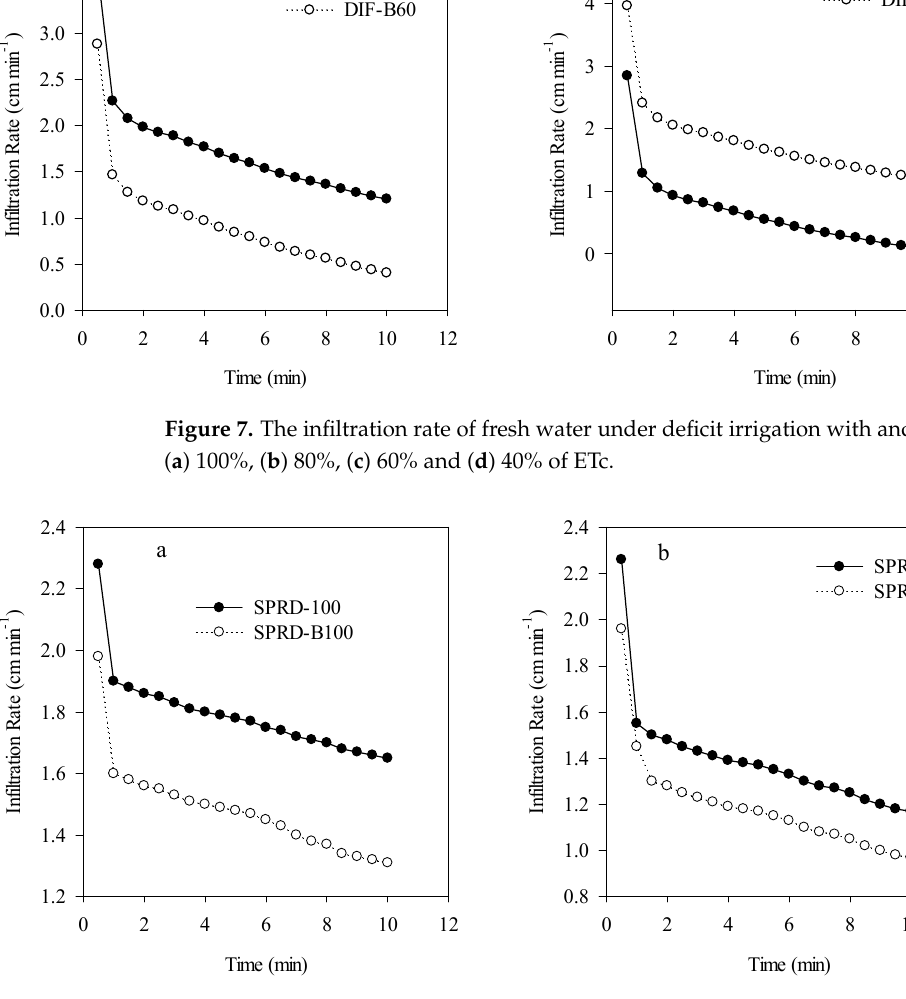
Figure 8. Infiltration rate under deficit irrigation by saline water with biochar and non-biochar, where ( a ) 100%, ( b ) 80%, ( c ) 60%, and ( d ) 40% of ETc. 4. Conclusions The management of irrigation water under dry conditions and water scarcity in- cludes different policies: application of soil amendment such as biochar and methods of irrigation. In general, the policies should tend to increase water use efficiency by reducing non-beneficial irrigation water uses or reducing delivered water to the crop. The adoption of both RDI and PRD with the addition of biochar improve farm irrigation systems. In this study, the application of date palm biochar under RDI and PRD increased the soil water content, especially in the surface layer of soil. The highest salinity distribution was ob- served in the sides of plants compared with under the dripper. Without biochar the salin- ity ranged between 0.5 and 1.4 dS·m − 1 , while in biochar SD it was 0.7 to 2.1 dS·m − 1 . The decrease between biochar and non-biochar was 10.29%, 13.52%, 10.32%, and 7.06%, re- spectively. Furthermore, the cumulative infiltration under PRD with saline water was 1.74,1.49, 1.46, 1.24, 1.87, 1.60, 1.58, 2.79 cm·min − 1 , for SPRD-B 100 , SPRD-B 1 , SPRD-B 2 , SPRD- B 3 , SPRD 100 , SPRD 1 , SPRD 2 , and SPRD 3 , respectively. The decreased was 7.18%, 7.25%,